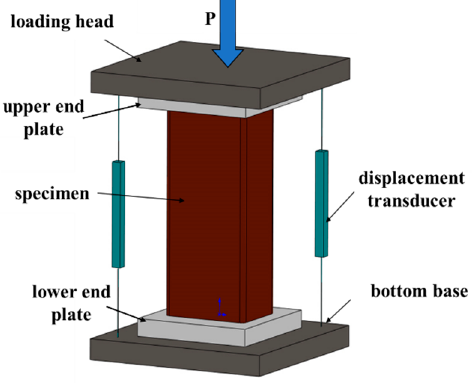
Figure 2. Test loading device.